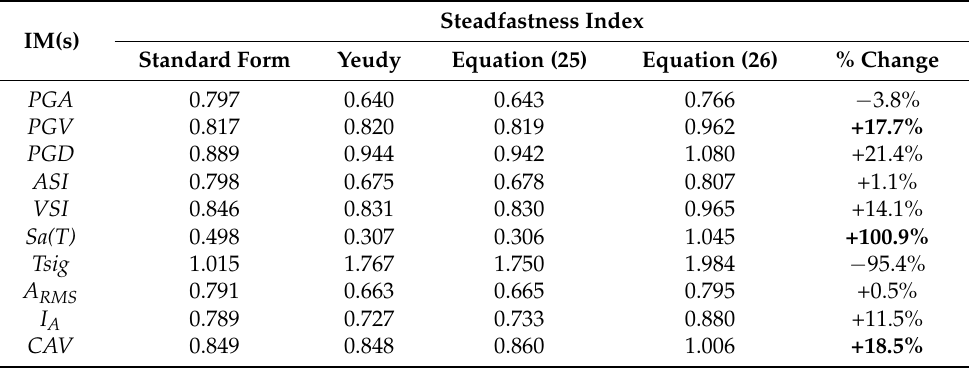
Table 8. Steadfastness analysis of different functional